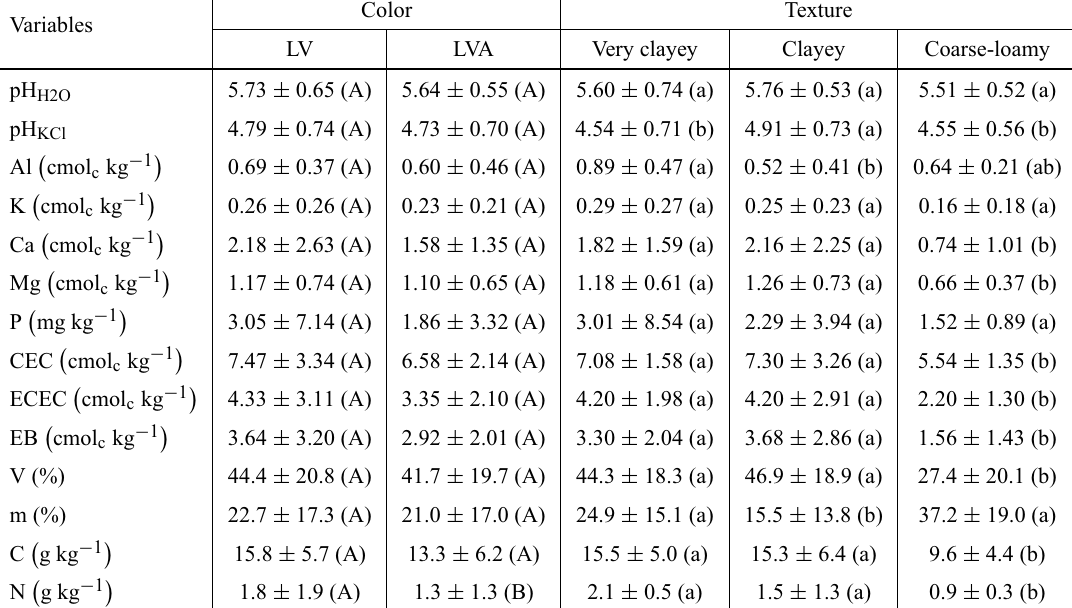
Comparison of topsoil (0.0–0.2 m) chemical properties (mean ± standard deviation) according to their classification in the Brazilian Soil Classification System (Santos et al. 2006).